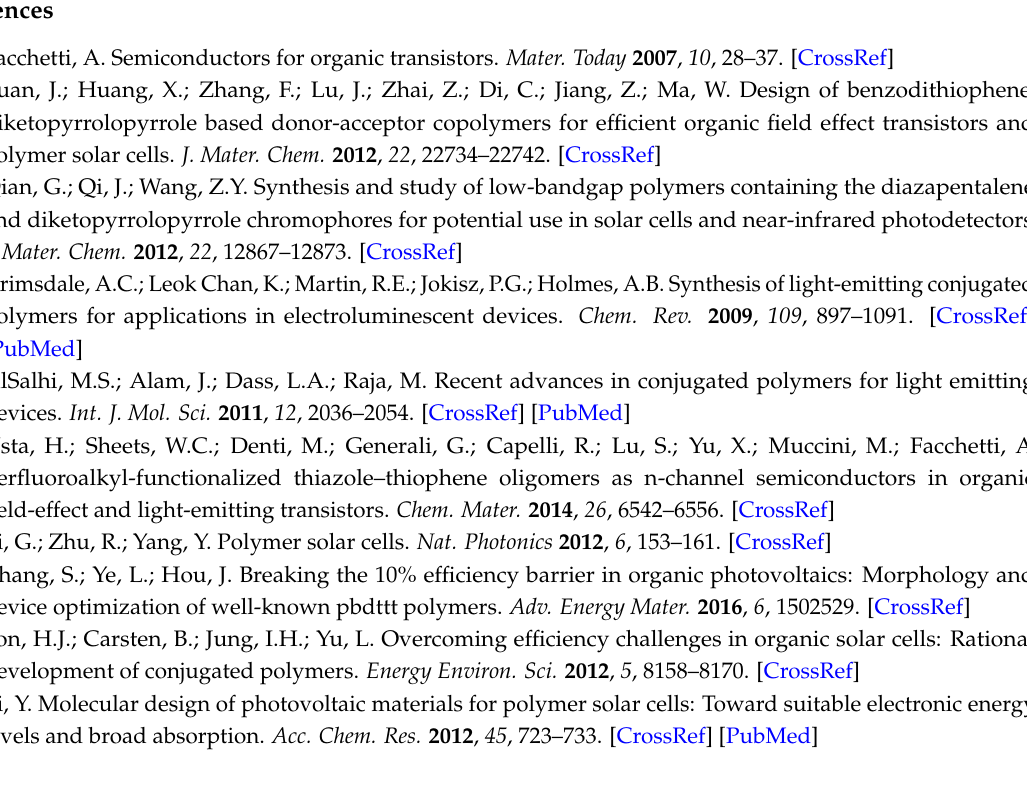
Figure S1: 1 H-NMR spectrum of Compound S2; Figure S2: 13 C-NMR spectrum of Compound S2; Figure S3: 1 H-NMR spectrum of Compound S3; Figure S4: 13 C-NMR spectrum of Compound S3; Figure S5: 1 H-NMR spectrum of Compound S4; Figure S6: 13 C-NMR spectrum of Compound S4; Figure S7: 1 H-NMR spectrum of Compound 1; Figure S8: 13 C-NMR spectrum of Compound 1; Figure S9: 13 C-NMR spectrum of Compound S6; Figure S10: 13 C-NMR spectrum of Compound S7; Figure S11: 1 H-NMR spectrum of Compound 3; Figure S12: 13 C-NMR spectrum of Compound 3; Figure S13: 1 H-NMR spectrum of Compound 4; Figure S14: 13 C-NMR spectrum of Compound 4; Figure S15: 1 H-NMR spectrum of Compound M1; Figure S16: 13 C-NMR spectrum of Compound M1; Figure S17: 1 H-NMR spectrum of Compound M3; Figure S18: 13 C-NMR spectrum of Compound M3; Figure S19: (a) TGA and (b) DSC second heating profiles of PTTVBDT, PTTVBDT-TPD, and PTTVBDT-DPP with a heating rate of 10 ◦ C/min under N 2 atmosphere and a cooling rate of 10 ◦ C/min; Figure S20: 1D-GIXRD out-of-plane of PTTVBDT, PTTVBDT-TPD, and PTTVBDT-DPP films which were prepared by drop-casting and then thermal annealing at 120 ◦ C, 20 mins; Figure S21: AFM (a–c) topography images and (d–f) phase images